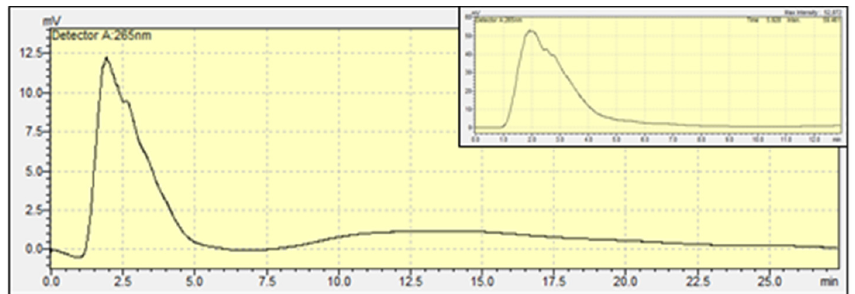
Fig. 1. HPLC analysis of extracted active material from expired drug compared with standard in small profile.